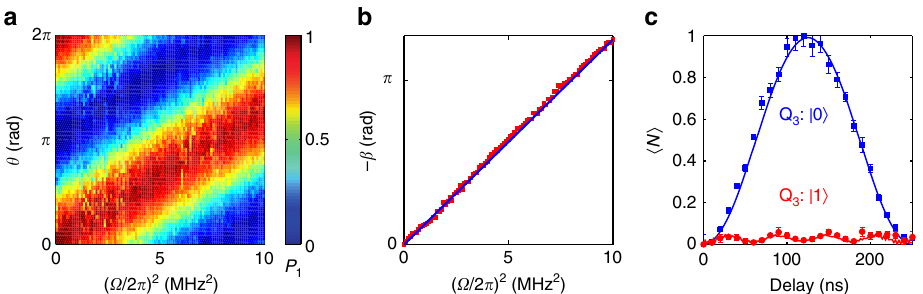
Fig. 2 Ramsey interference for geometric phase. a Occupation probability P 1 of Q 3 in 1 j i as a function of θ and Ω 2 , which is measured using the pulse sequence shown in Fig. 1d with the drive detuning δ /2 π = 4 MHz. b − β vs. Ω 2 (red dots), where β is obtained by tracing the P 1 -maximum contour in a : For each Ramsey trace of P 1 vs. θ sliced along a fi xed Ω 2 , we perform the cosinusoidal fi t with the phase offset giving the value of β . The blue solid line shows the theoretical result. c Measured average photon numbers with error bars of the resonator as functions of time during the application of the microwave drive with Ω /2 π = 2 MHz conditional on the qubit states 0 j i (blue dots) and 1 j i (red dots). Error bars represent statistical errors (s.d.) of repeated sets of measurement. Lines are the the target basis, and the four-qubit controlled – controlled –